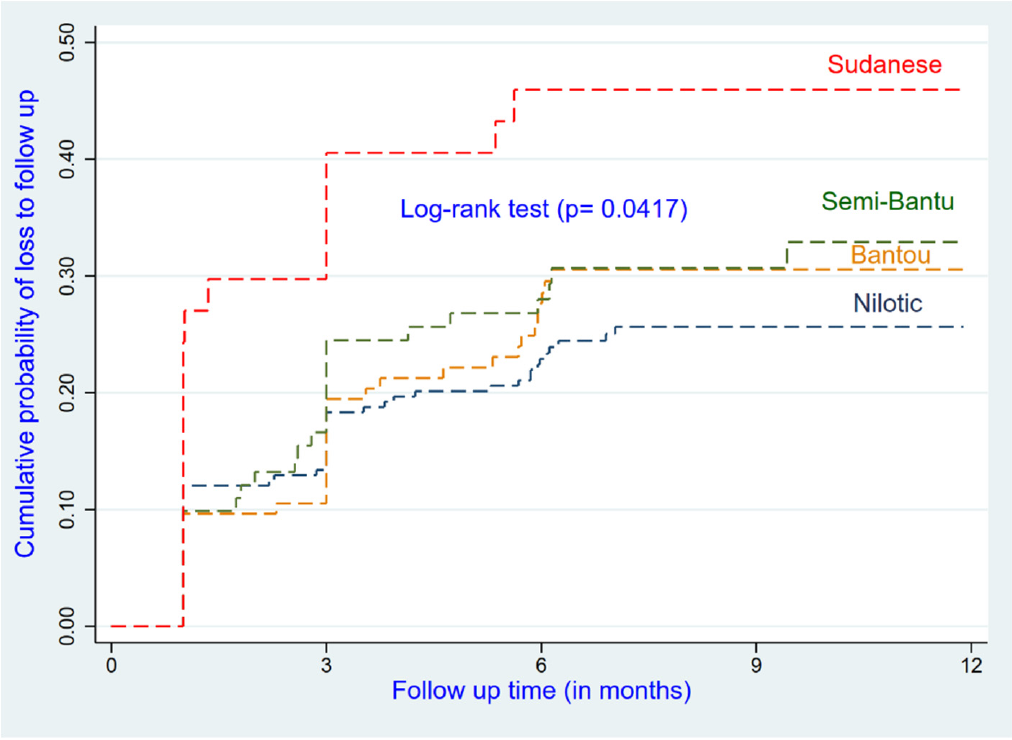
Figure 1. Cumulative incidence of LTFU by ethnic groups.